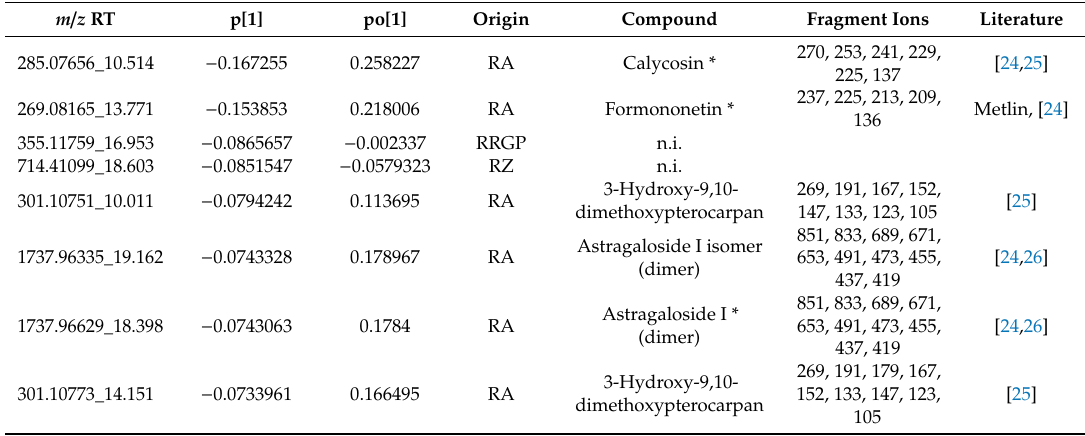
Table A3. Hits for the inhibitory activity of HQJZT against IL-1 β